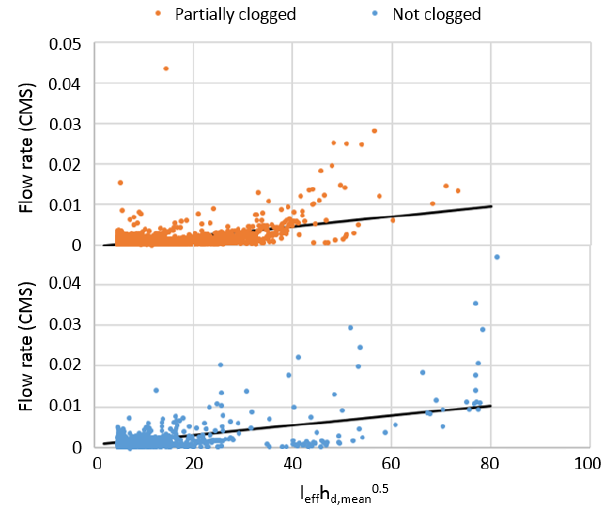
Figure 9. Performance plotted as flow rate vs. ℎ 𝑑,𝑚𝑒𝑎𝑛 𝑙 𝑒𝑓𝑓 for all data.